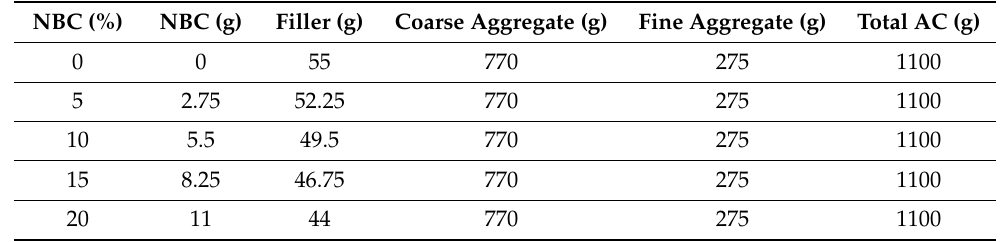
Figure 1. Aggregate gradation. Table 1. Amounts of aggregate, filler, and NBC.